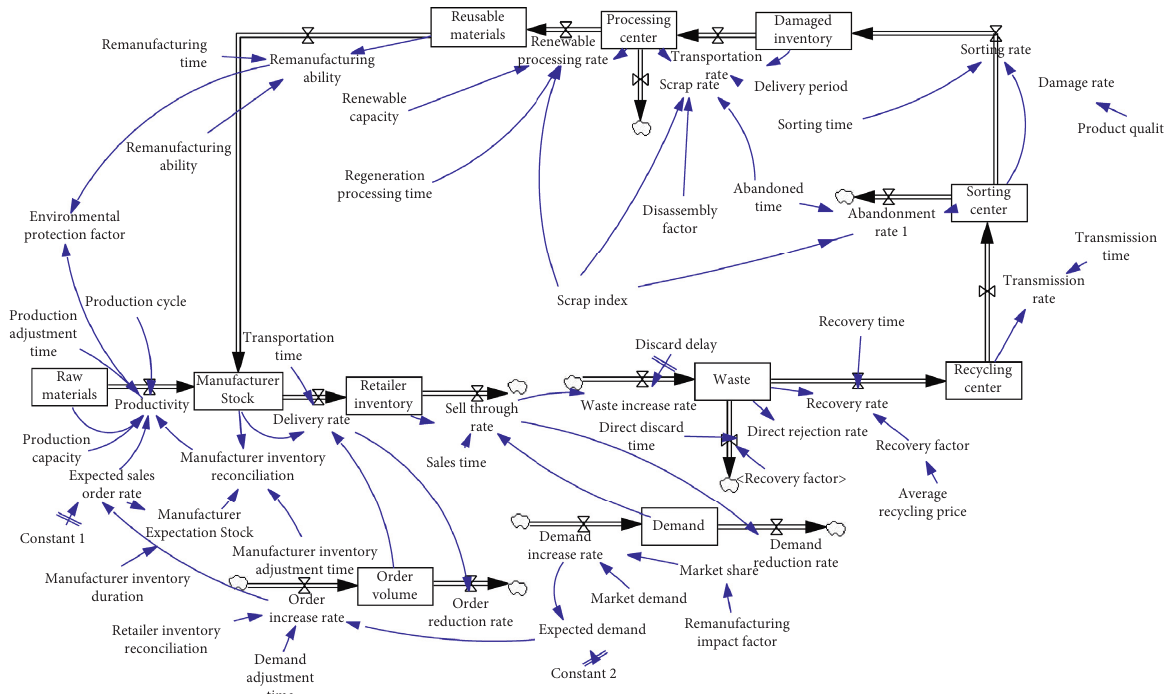
Figure 5: Dynamic model of Gree’s original recycling framework system.